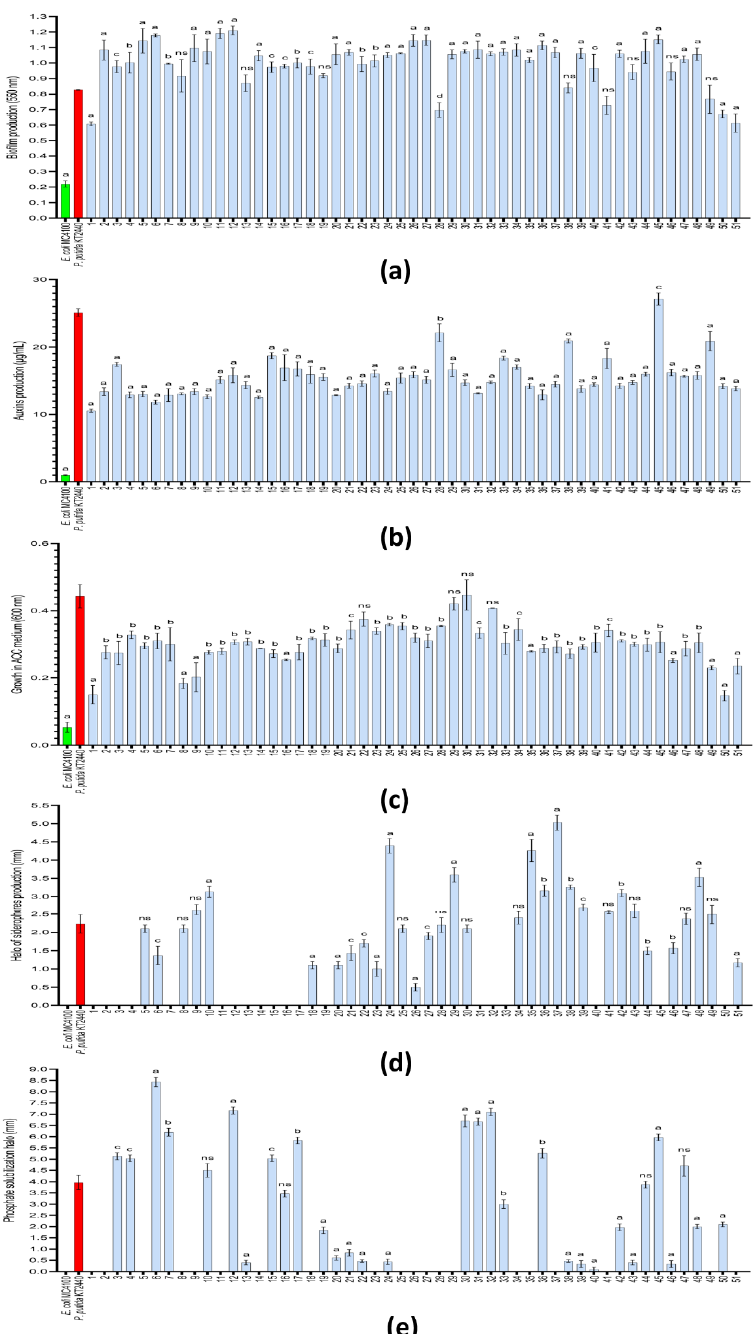
Figure 7. Comparison of biochemical tests carried out on the isolated strains. The bar graphs show the production of ( a ) biofilm and ( b ) auxins; ( c ) the growth recorded in ACC medium as the sole nitrogen and carbon source (indicative of ACC deaminase production); ( d ) the production of siderophores (mm of halo); and ( e ) the solubilization of phosphate (mm of halo), from three independent experiments (n = 3). The numbers of each column indicate the strain evaluated (see Table 3). The column in green represents E. coli (control), and the column in red represents P. putida (control). The sets of data were compared using a two-way ANOVA test and 95% confidence intervals (with Tukey’s post-tests), where letters indicate a statistically significant difference at a p < 0.0001; b p < 0.001; c p < 0.01 and d p < 0.01, compared to the values recorded in the main control strain, P. putida KT2440; ns stands for statistically non-significant. Error bars represent